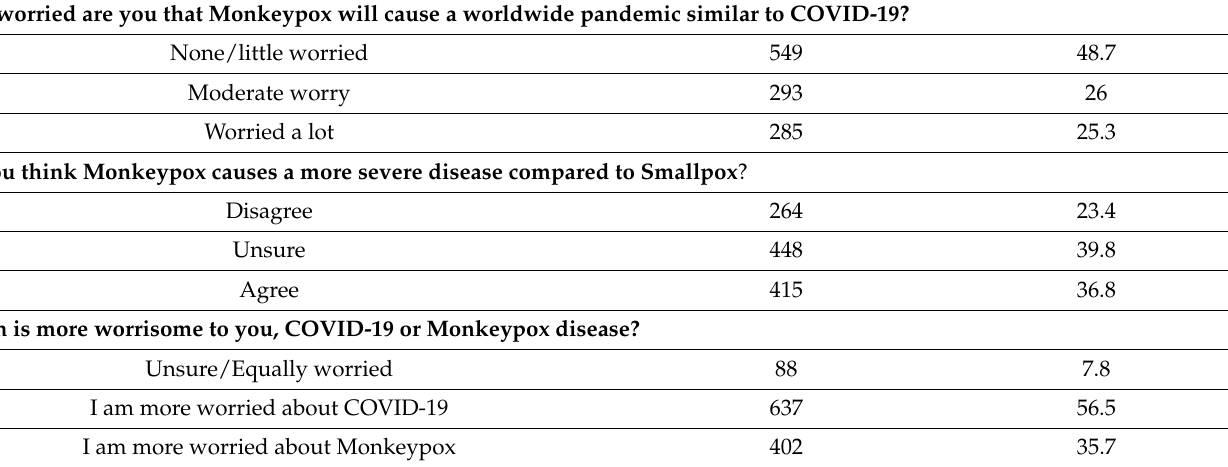
Table 3. HCW’s Monkeypox disease perceptions and